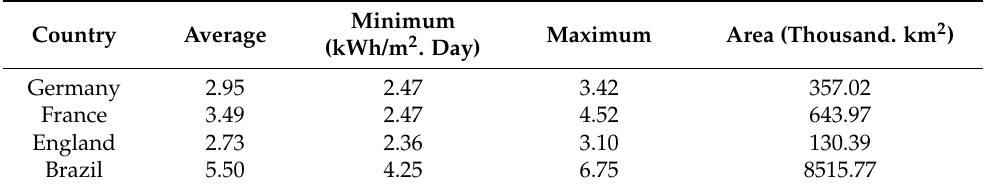
Figure 7. Annual average daily horizontal radiation. Pins show the location of the studied PV plants. Coordinate system: Datum Sirgas 2000. Data Source: [49,51]. Table 2. Technical specifications of the evaluated photovoltaic plants. Table 1. Daily solar irradiance and area by